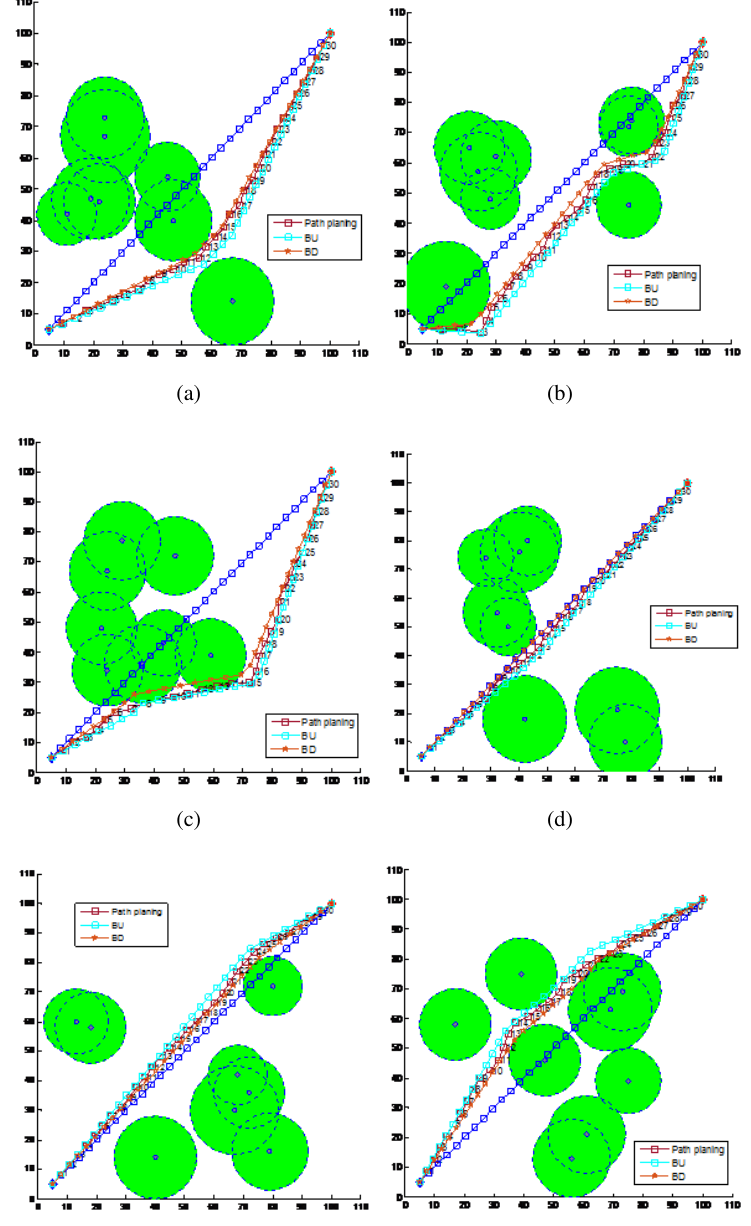
Fig. 11 The results of different experiments under random static threats